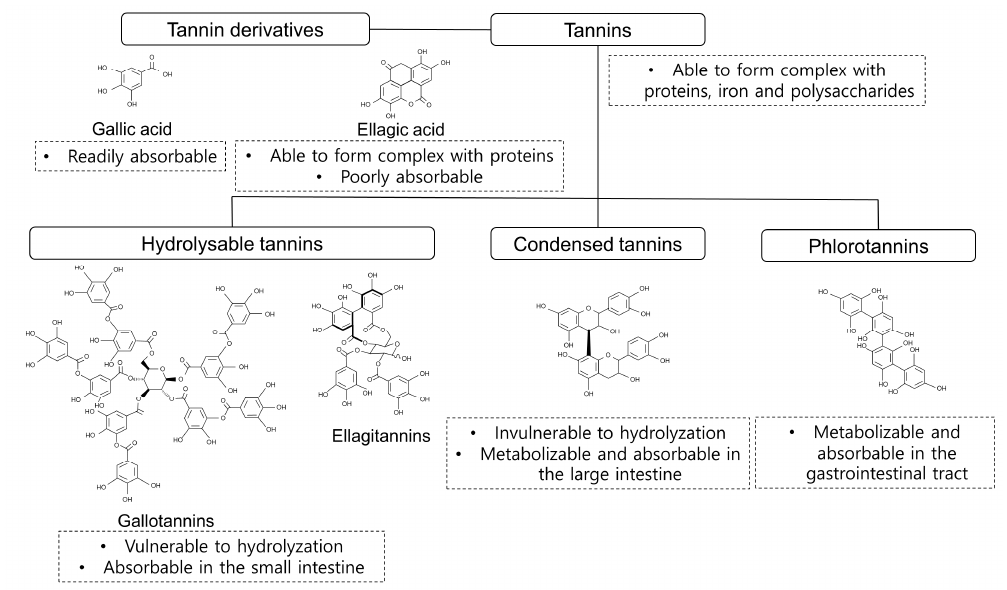
Figure 1. Classification and examples of molecular structure of tannins. Hydrolysable tannins and condensed tannins belong to plant tannins, and phlorotannins are found in brown algae.